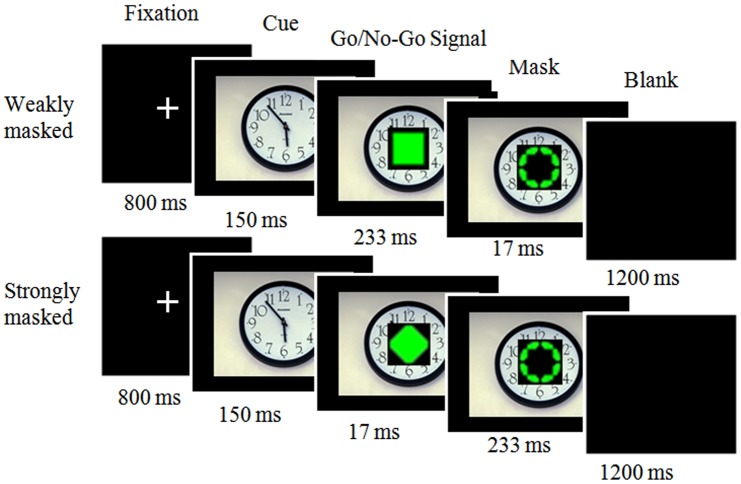
Procedure and design of Experiments.Participants were engaged in a masked Go/No-Go task superimposed on fearful, disgusting, or neutral emotional contexts.